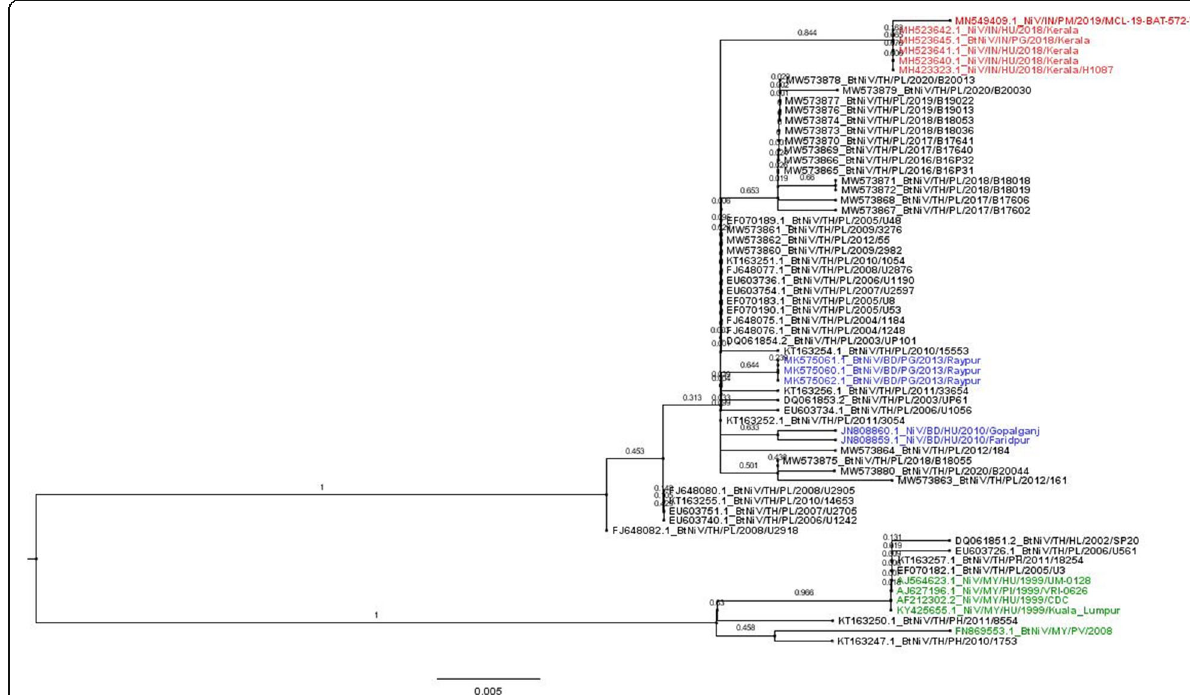
Fig. 2 Phylogenetic tree of Nipah virus (NiV) genes found in P. lylei bats in Thailand: partial coding sequence (cds) of nucleocapsid (N) gene (357 bp). NiV positive sequences from this study and previous reports, from 2002 to 2020, were analyzed. Maximum-likelihood method was used to analyze NiV phylogeny based on the Kimura 2-parameter model. Bootstrap values were determined using 1000 replicates via MEGA X. Forty- seven NiV found in Thailand (21 from this study) were selected for phylogenetic analysis. Identical NiV from P. lylei were not included in the analysis. Thai NiV is shown in black (Full list can be found in Supplementary Table 1), while the reference sequences used in this study are shown in red (India), blue (Bangladesh) and green (Malaysia) respectively. BD = Bangladesh, IN = India, TH = Thailand, MY = Malaysia; PG = Pteropus giganteus , PL = Pteropus lylei , PH = Pteropus hypomelanus , HL = Hipposideros larvatus , HU = Human, PI = Pig, Bt =